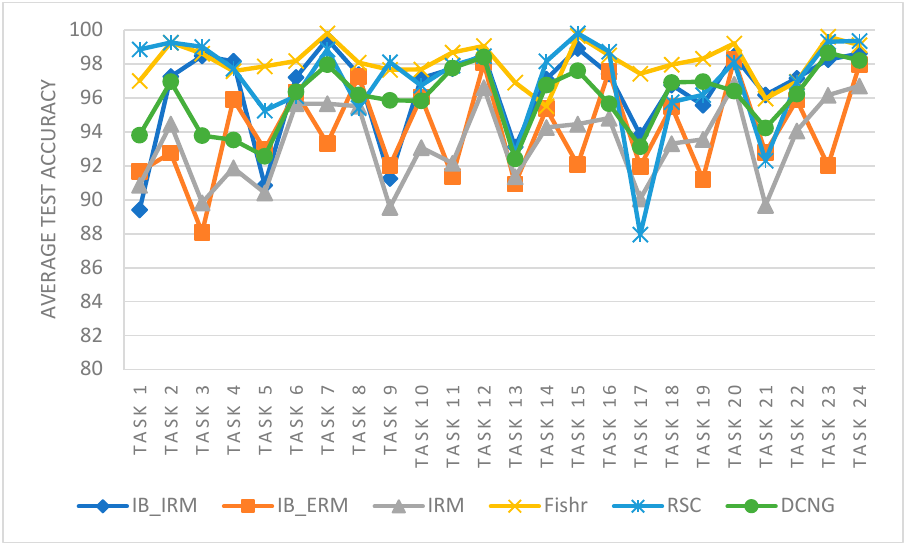
Figure 5. Performance comparison of different generalization methods on CWRU data sets. Table 2. DCNG transfer tasks on CWRU data sets.